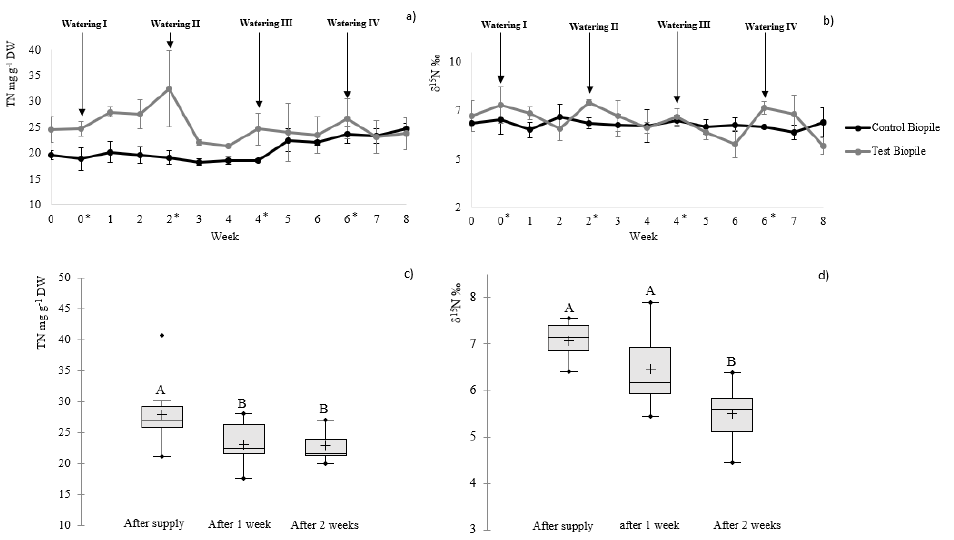
Figure 3. ( a ) Temporal evolution of the total nitrogen (TN) concentration; ( b ) temporal evolution of the isotopic signature (δ 15 N) (* means after watering, and the error bars represent standard deviations ( n = 3)); ( c ) monitoring of the total nitrogen (TN) abatement evolution in the test biopile; and ( d ) the isotopic signature (δ 15 N) ( n = 3) evolution in the test biopile. Different letters above boxplots indicate a significant difference between plots according to the Kruskal–Wallis test with Dunn’s procedure, ( a – c ) p value = 0.05, ( d ) p value = 0.001.